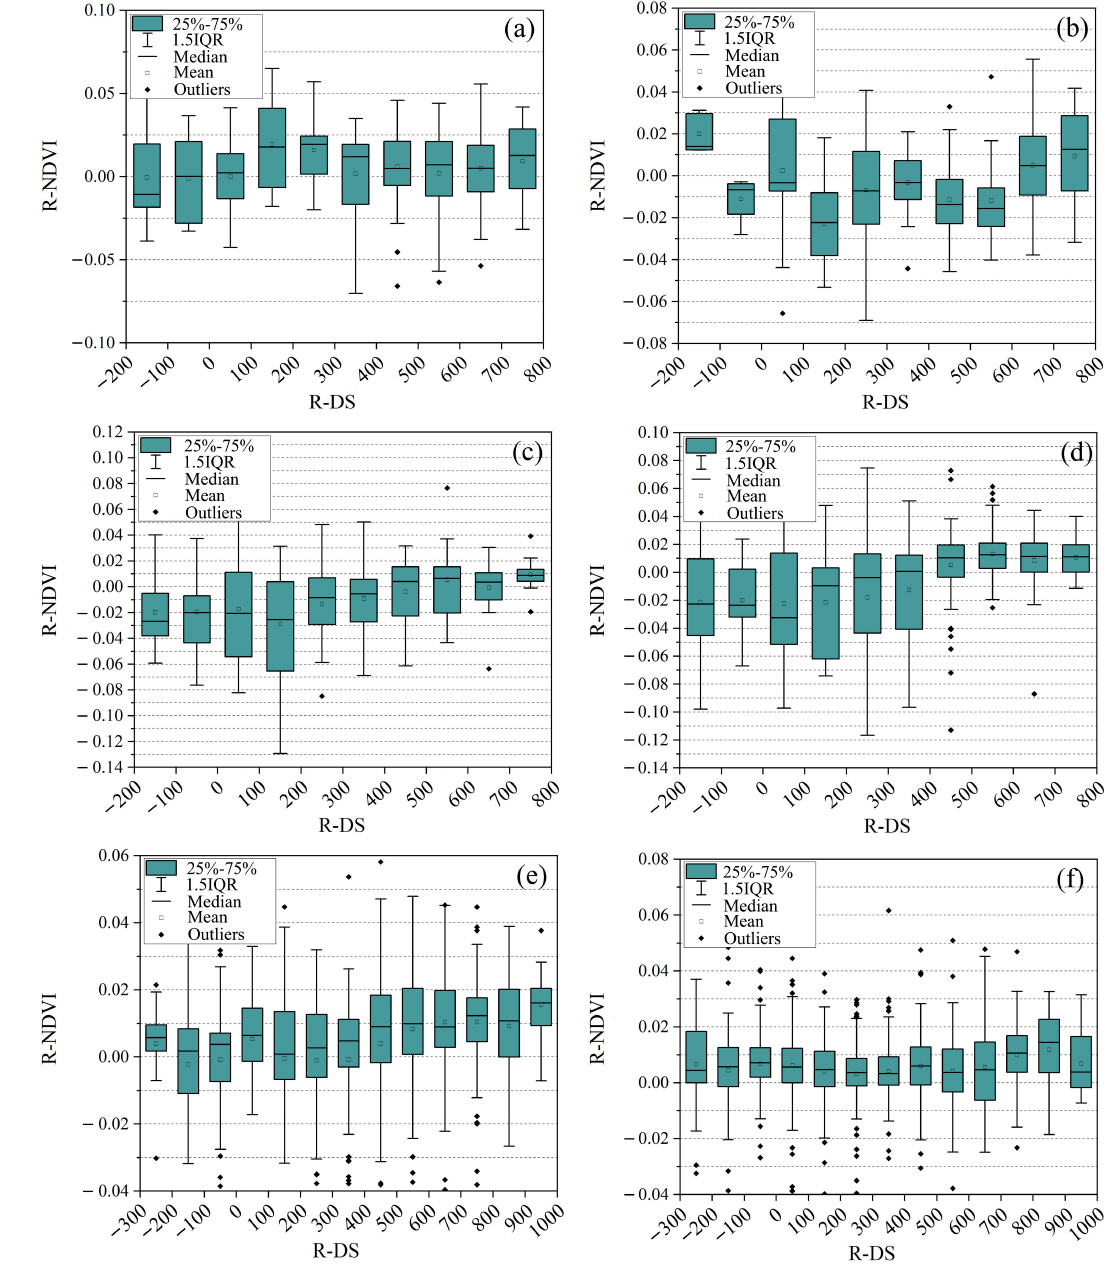
Figure 10. The relationships between R-DS and R-NDVI for di ff erent elevation bands: ( a ) < 2000 m, ( b ) 2000–3000 m, ( c ) 3000–4000 m, ( d ) 4000–4500 m, ( e ) 4500–5000 m, and ( f ) 5000–5500